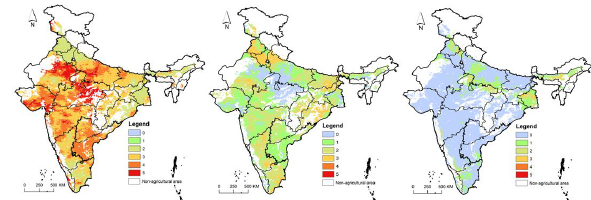
Figure 7 Frequency of Meteorological drought from 1982-1992, 1993- 2002 and 2003-2015